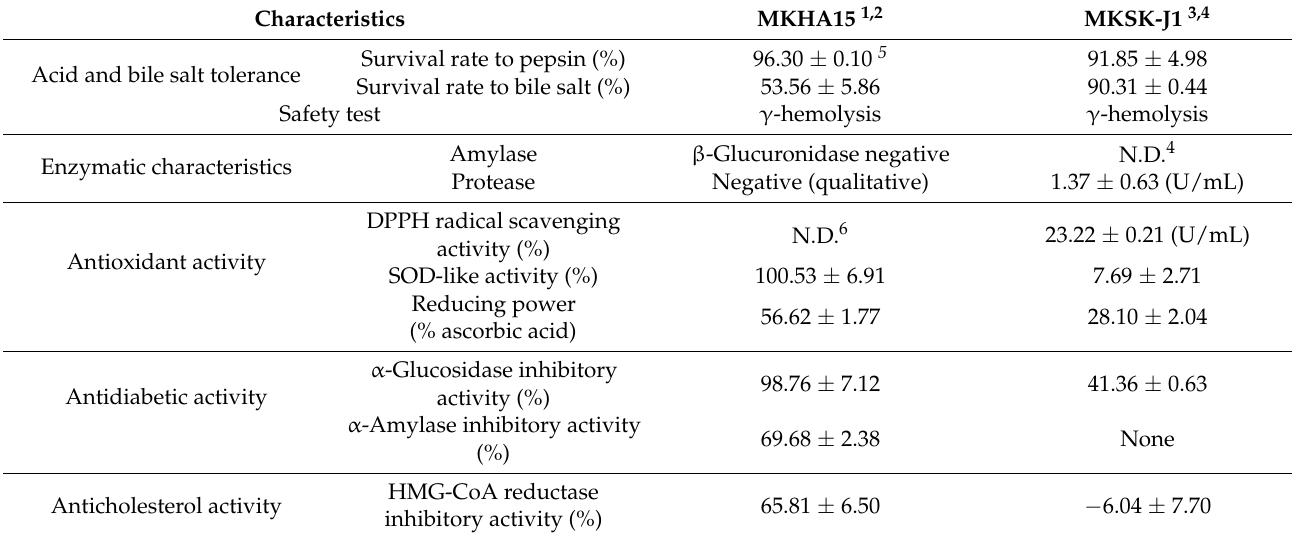
Table A1. Probiotic and physiological characteristics of MKHA15 and